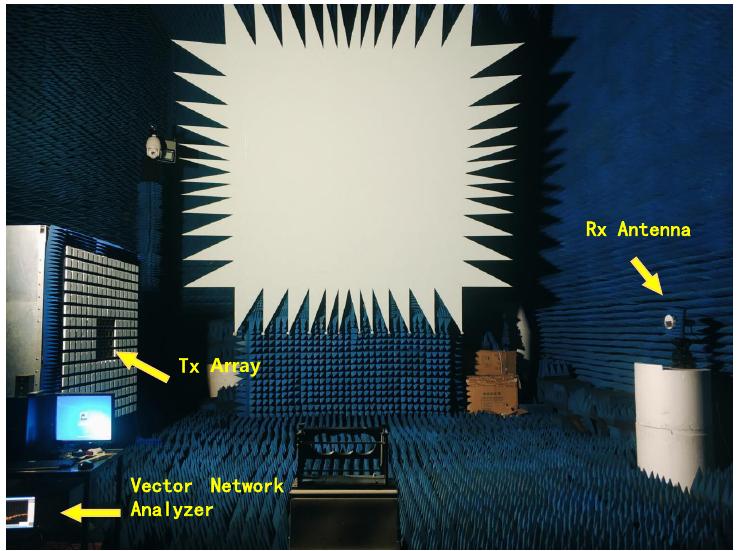
Figure 3. The front view of the experimental system with a measurement distance of 5.85 m. Note that the “far-field on/off” calibration method can be used as the reference method in the paper since the on/off operation is supported with the experimental setup. The array calibration results at 3.5 GHz using the “far-field on/off” and “face-to-face” methods are shown in Figure 4. A power deviation up to ± 1 dB and a phase deviation up to ± 10 ◦ across the antenna elements can be observed for both reference calibration methods, indicating the different initial excitation among RF branches. The measured results demonstrated that the “face-to-face” method can only be used for rough array calibration, and it might be not sufficient for accurate antenna array calibration. In the analysis below, the “far-field on/off” calibration method can be selected as the reference to evaluate the accuracy of different array calibration results.